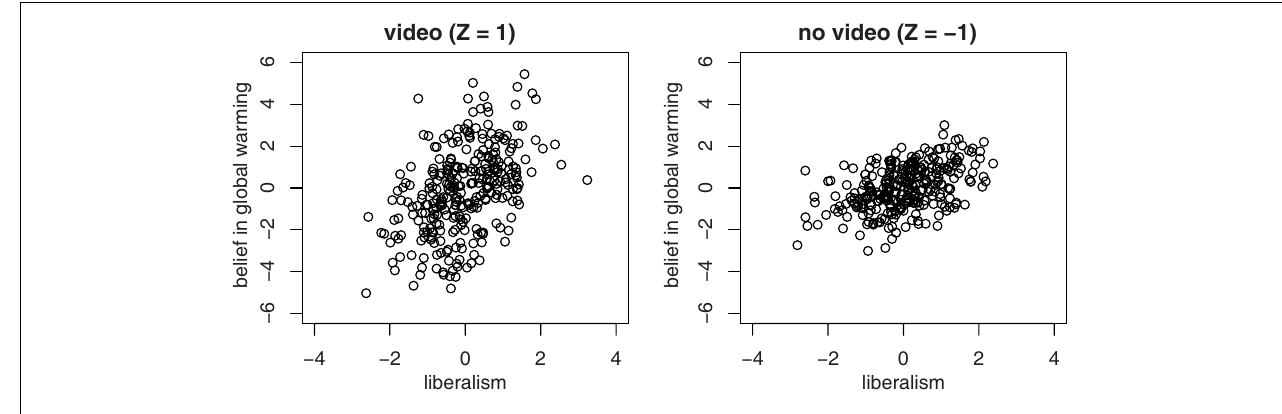
FIGURE 3 | Scatter plots for the two-condition